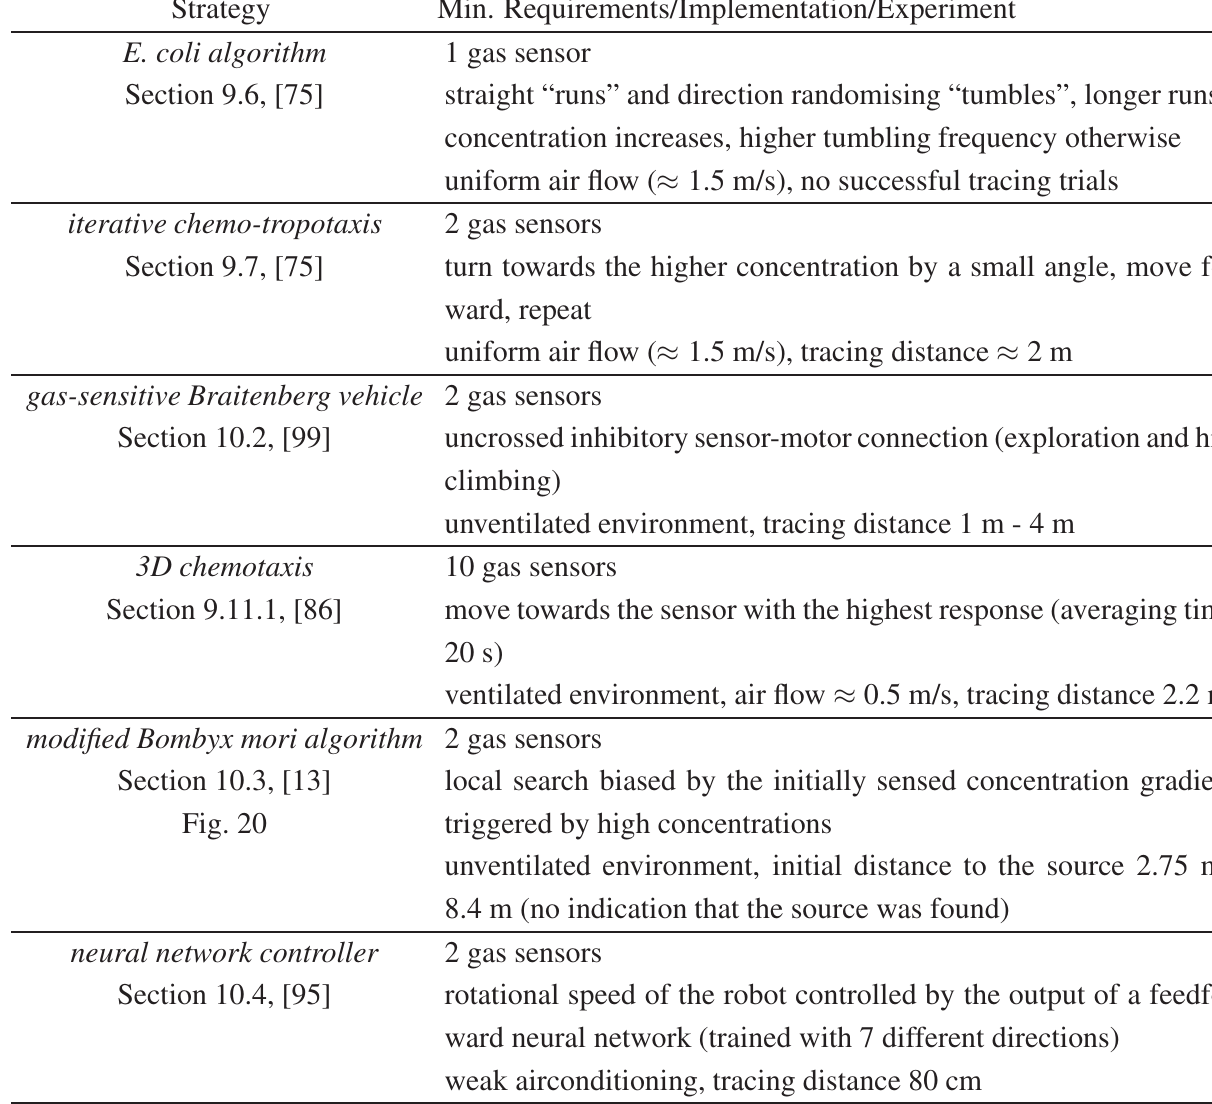
Table 2 . Gas source tracing strategies that were experimentally tested on a mobile robot and do not require information about the